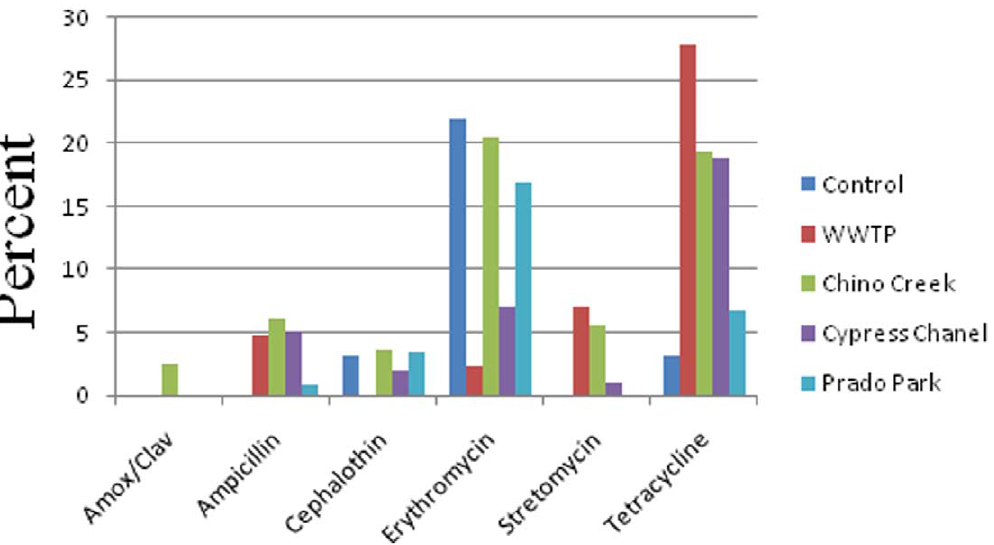
Figure 3. Antimicrobial resistance (%) from five zones within the watershed. A total of 600 isolates were characterized for antimicrobial sensitivities.